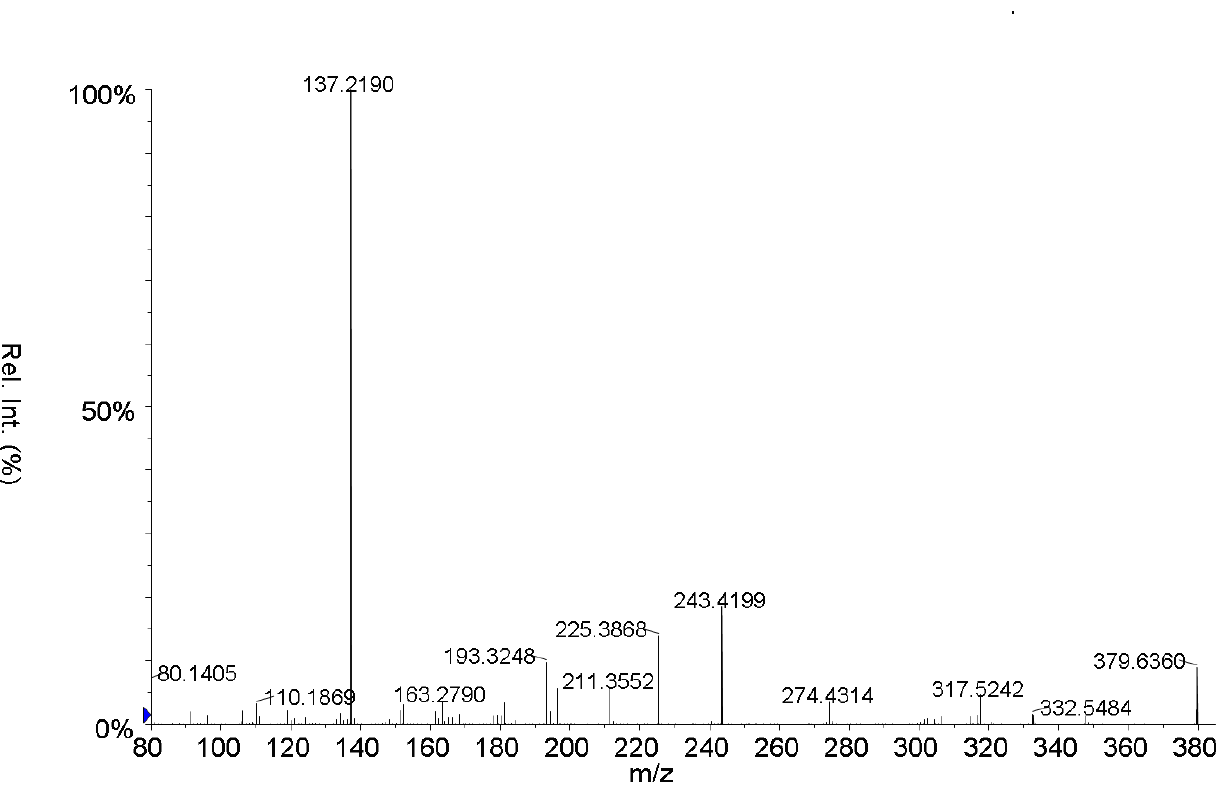
The determination of the tyrosol residue (TYR, 6 ) and hydroxytyrosol (HTYR, 7) (Scheme 2)